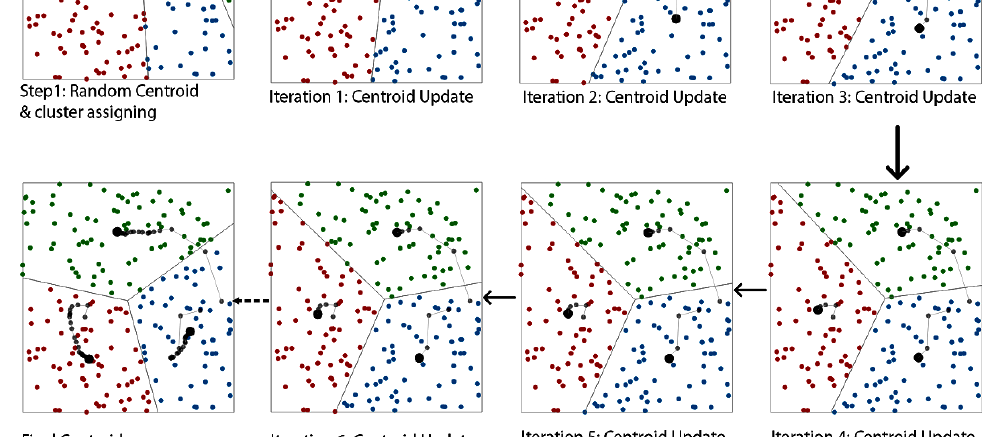
Figure 17. K-Means Clustering.